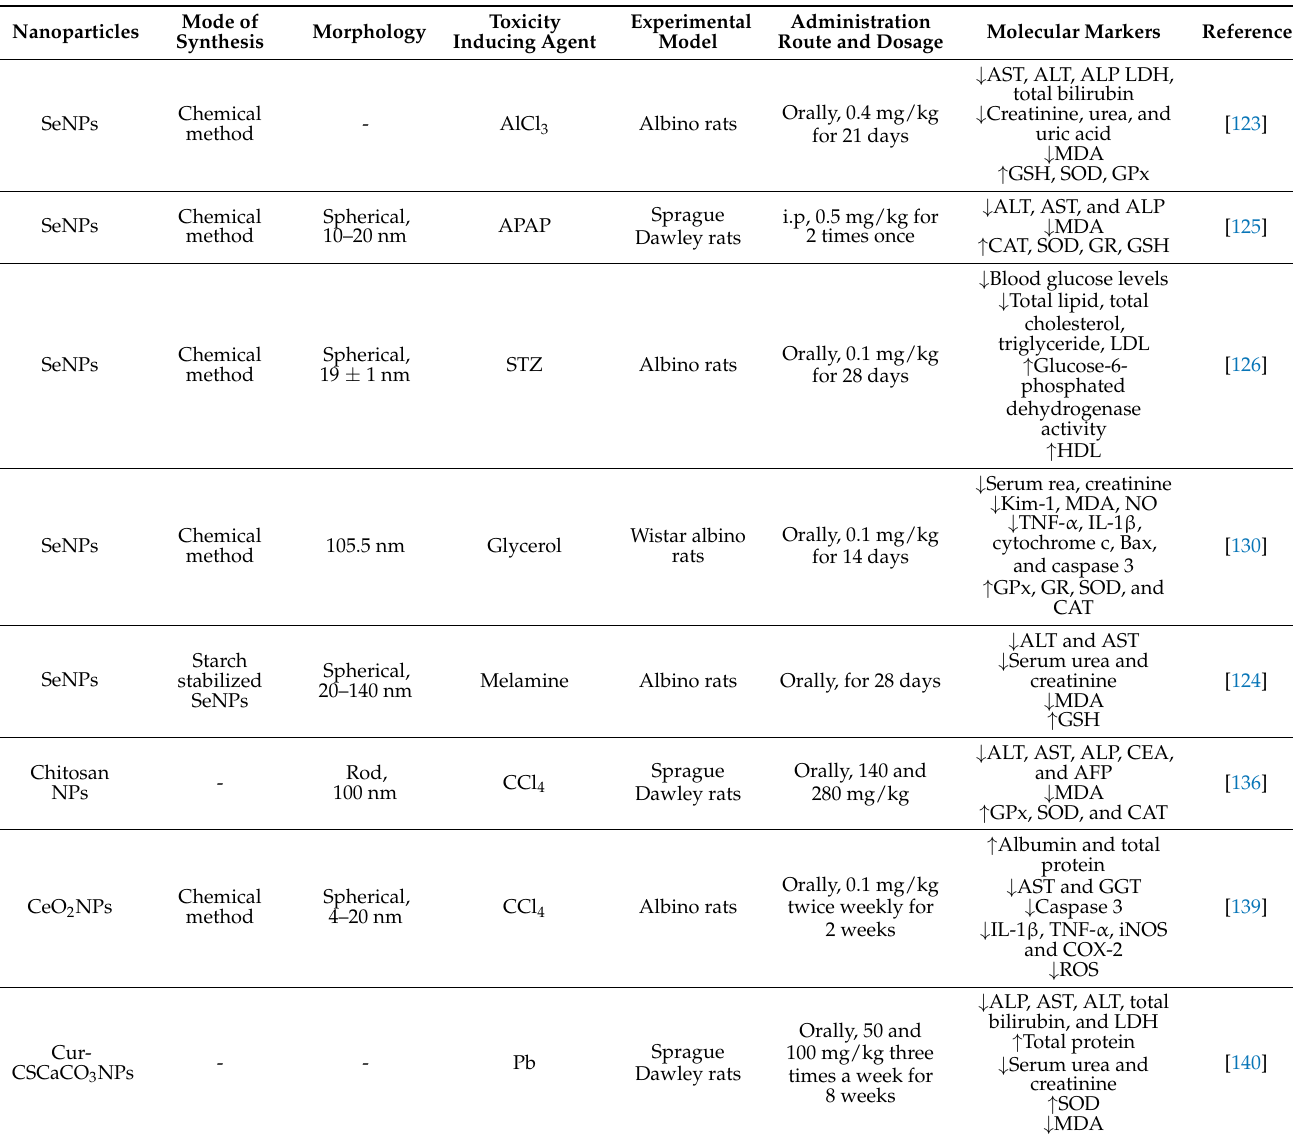
Table 4. Summary of the ameliorative effects of other NPs against hepato-renal